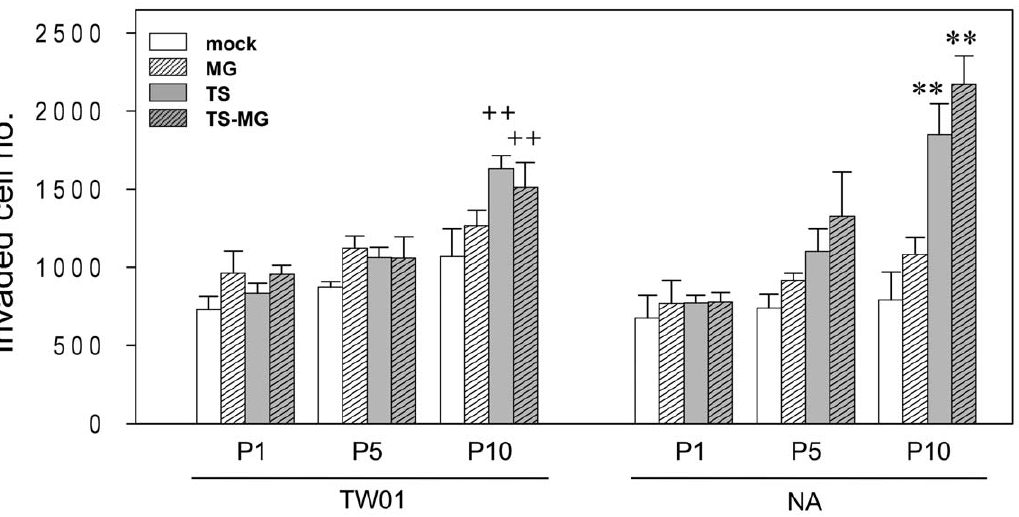
Figure 3. Recurrent EBV reactivations promote the invasiveness of NPC cells. EBV reactivation increases invasiveness, dependent on the number of rounds of reactivation. Mock or chemically-treated TW01 and NA cells were assayed for their ability to invade a Matrigel-coated membrane. Data indicate the average number of invading cells in three independent experiments (mean 6 SD). ++ : p , 0.01, when compared to the TW01-P1/mock cells; **: p , 0.01, when compared to the NA-P1/mock cells.